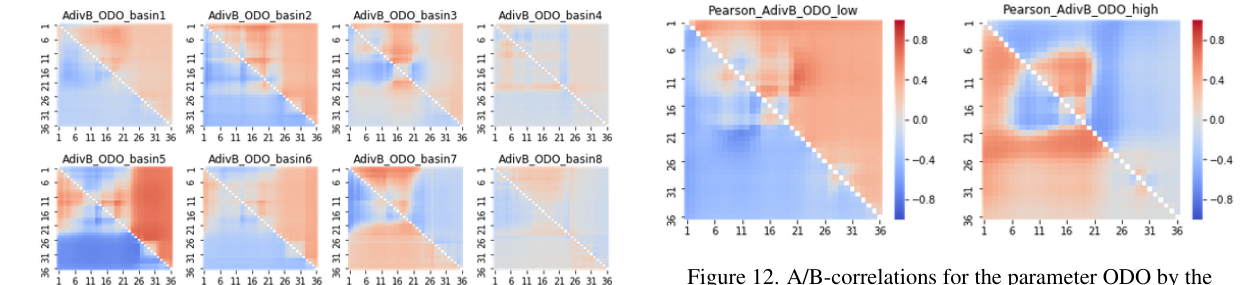
Figure 12. A/B-correlations for the parameter ODO by the parameter